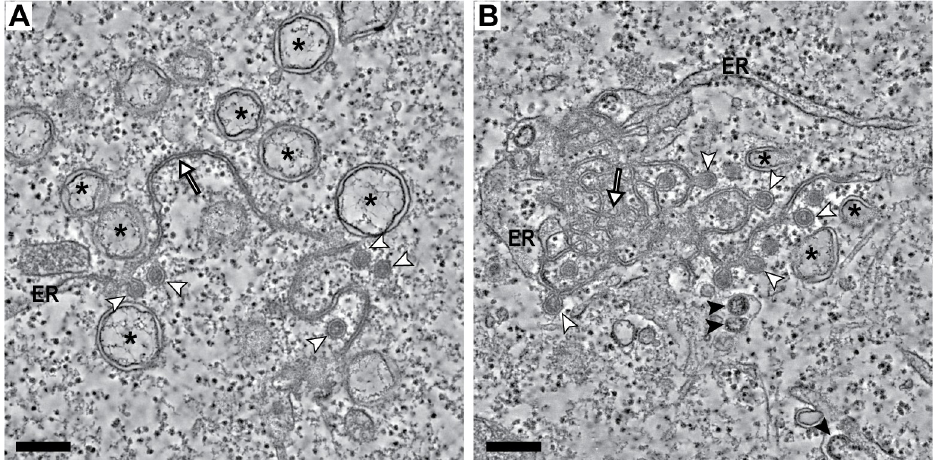
Fig 2. Membrane structures induced by gamma-CoV infections. Tomography of Vero cells infected with IBV, fixed at 16 hpi, and processed for EM following the same protocol as for MERS-CoV-infected cells (Fig 1). Tomographic slices through 2 regions containing IBV-induced membrane modifications. These include DMVs (asterisks), DMSs (white arrowheads), and zippered ER (white arrows). Most zippered ER consists of long stretches of ER-derived paired membranes (A), though branching zippered ER, closer to the CM described for beta-CoV, was also present. (B) Virus particles (black arrowheads) budding into the ER membranes were often observed. Scale bars, 250 nm. CM, convoluted membranes; CoV, coronavirus; DMS, double-membrane spherule; DMV, double-membrane vesicle; EM, electron microscopy; ER, endoplasmic reticulum; hpi, hours postinfection; IBV, infectious bronchitis virus; MERS-CoV, Middle East respiratory